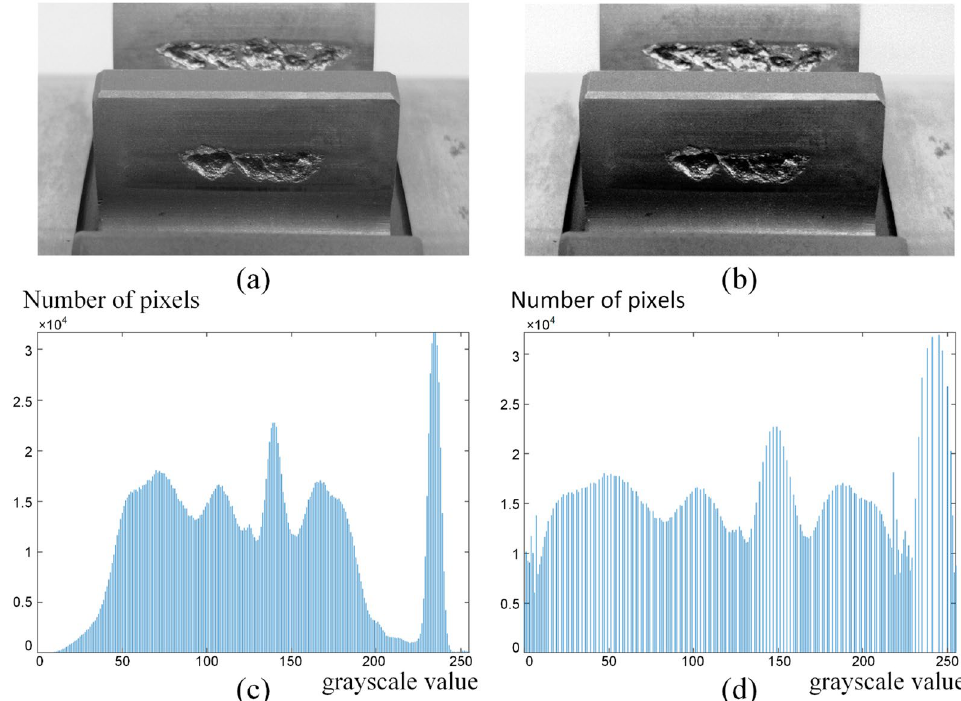
Figure 9 Tooth surface of the histogram equalization: a original image, b result image, c gray distribution of acquired image, d gray distribution of enhanced